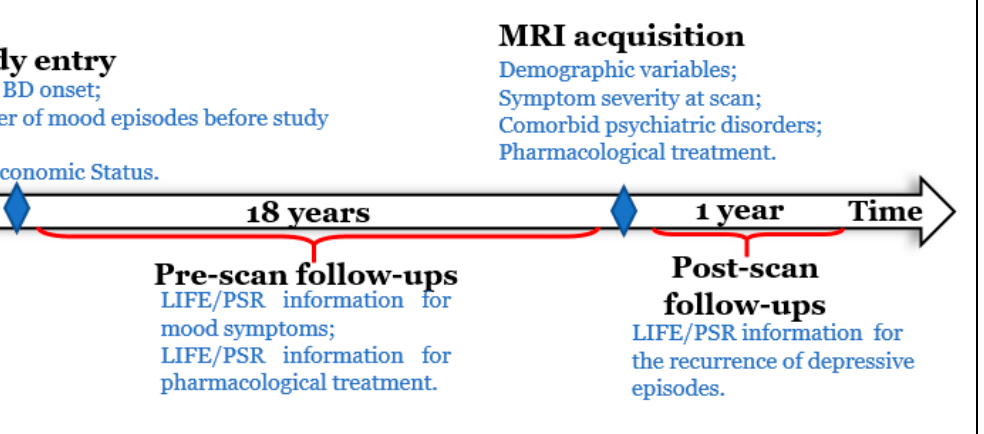
Figure 1. Study timeline. Figure 1 shows the timeline and assessments of the study. There are four main sources of information in this study: (1) Study entry, (2) pre-scan follow-ups, (3) MRI acquisition, and (4) post-scan follow-ups. At study entry, information regarding age of BD onset, number of mood episodes before study entry (during childhood and adolescence), and socioeconomic status was collected. Pre-scan follow-ups assessed severity and frequency of depression, mania, and hypomania using LIFE. These symptoms were assessed on a weekly basis for the interval between follow-ups. Information regarding long-term exposure to medications (antidepressants, mood sta- bilizers, antipsychotics, stimulants, and benzodiazepines) was also assessed. At MRI visit, all BD participants were assessed for symptom severity, comorbid psychiatric disorders, and current pharmacological treatment in addition to the neuroimaging acquisition. A total of 70 participants had study-entry, pre-scan follow-up, and usable neuroimaging data. Neuroimaging data and cross-sectional assessments were also acquired for 39 HCs. Post-scan follow-ups used LIFE/PSR to identify the recurrence of depressive episodes. Depressive episodes were defined as two or more consecutive weeks of PSR ≥ 5 for depression. Fifty-two participants showed post-scan follow-up data. Abbreviations: BD, Bipolar Disorder; LIFE, Longitudinal Interval Follow-up Evaluation; PSR, Psychiatric Status Ratings; HC, Healthy Controls.